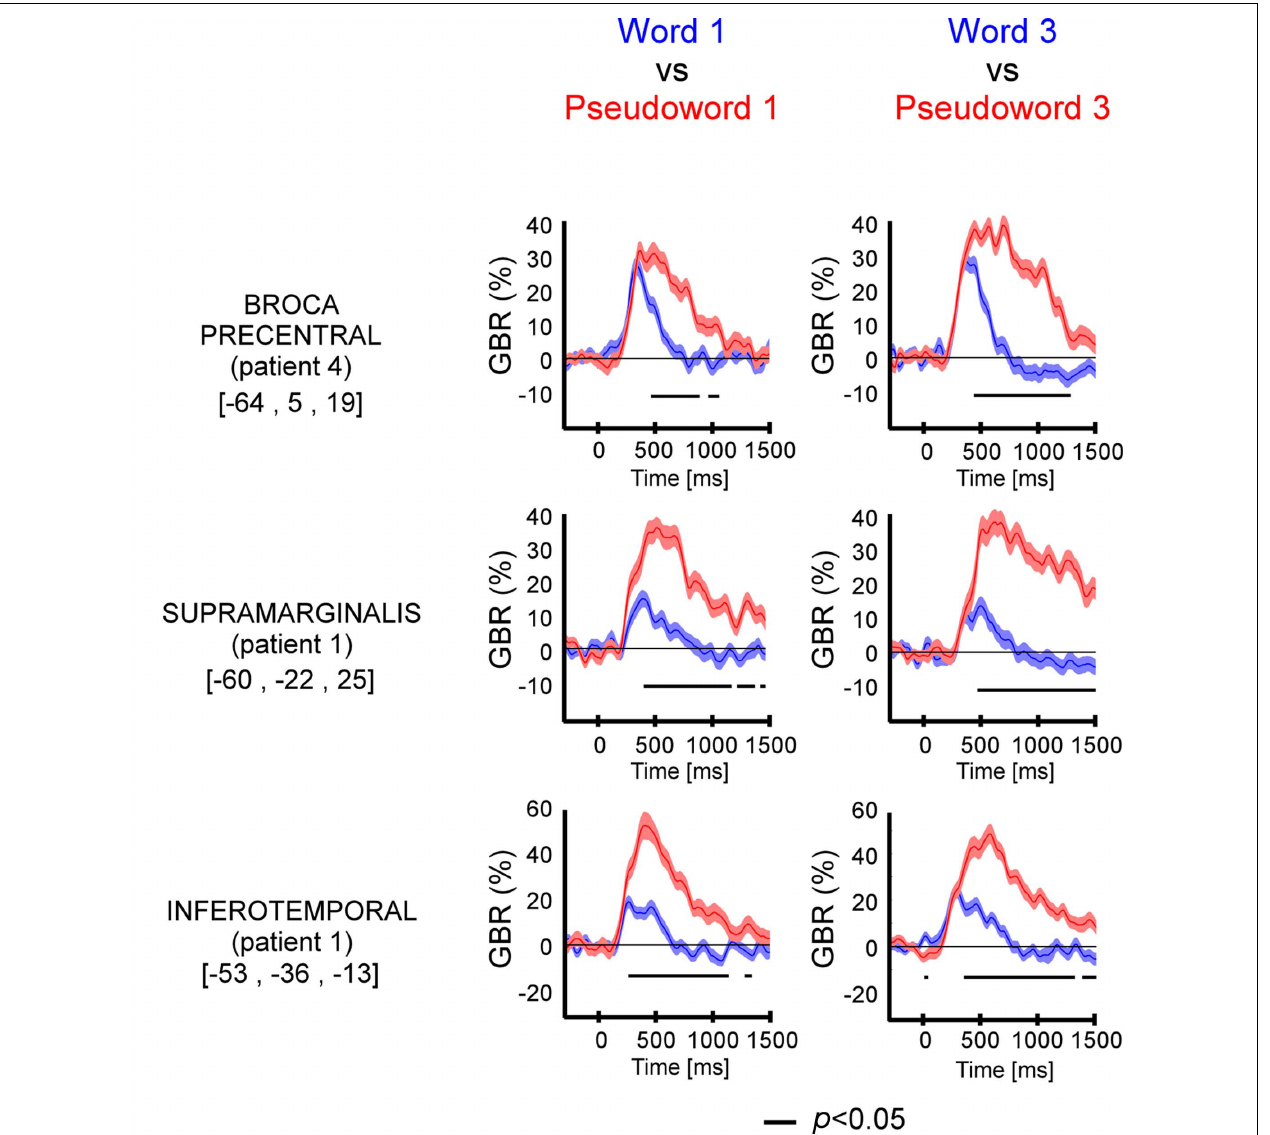
Items length induced stronger and longer GBR for pseudo-words, compared to words.Thus, across sites and for all patients, the length shows significant effect only for pseudo-words. For each region theTalairach coordinates are